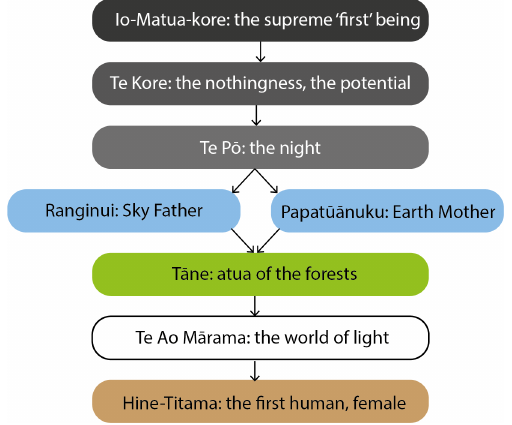
Figure 1. The pedigree of mankind in Te Ao M¯aori . Modified from Graham